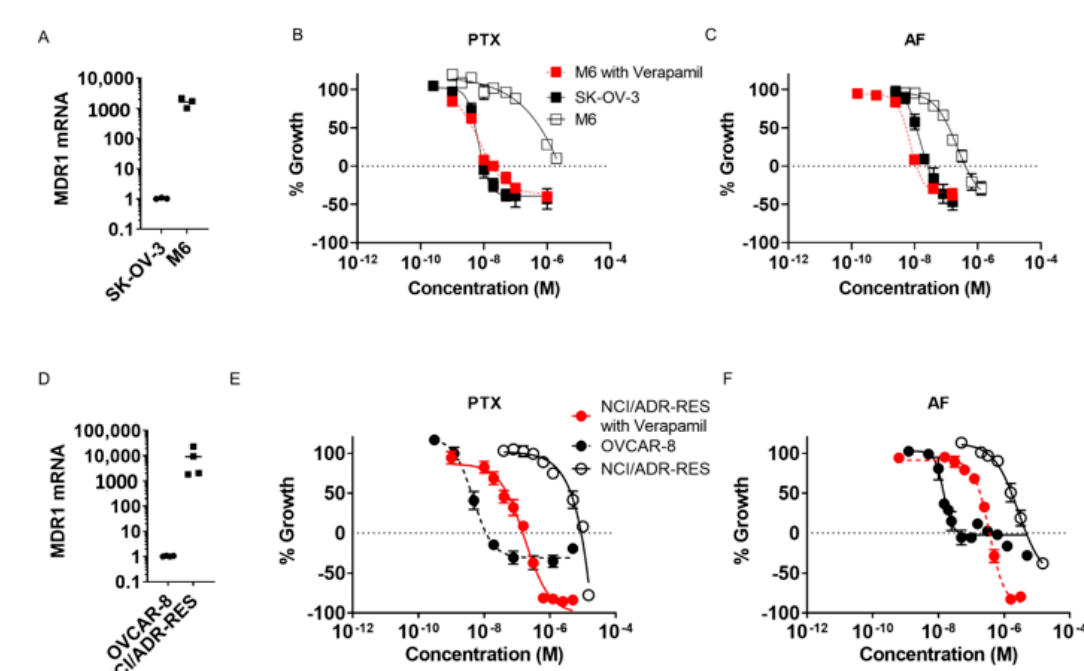
Figure 2. Taccalonolide AF is less susceptible to Pgp-mediated resistance than paclitaxel. ( A ) MDR1 transcript levels in SK-OV-3 and SK-OV-3-MDR-1-6/6 (M6) cells and ( B , C ) concentration-response curves of paclitaxel (PTX) or taccalonolide AF with or without 10 µ M verapamil. ( D ) MDR1 transcript levels in OVCAR-8 and NCI/ADR-RES cells and ( E , F ) concentration-response curves of PTX or taccalonolide AF with or without 5 µ M verapamil.